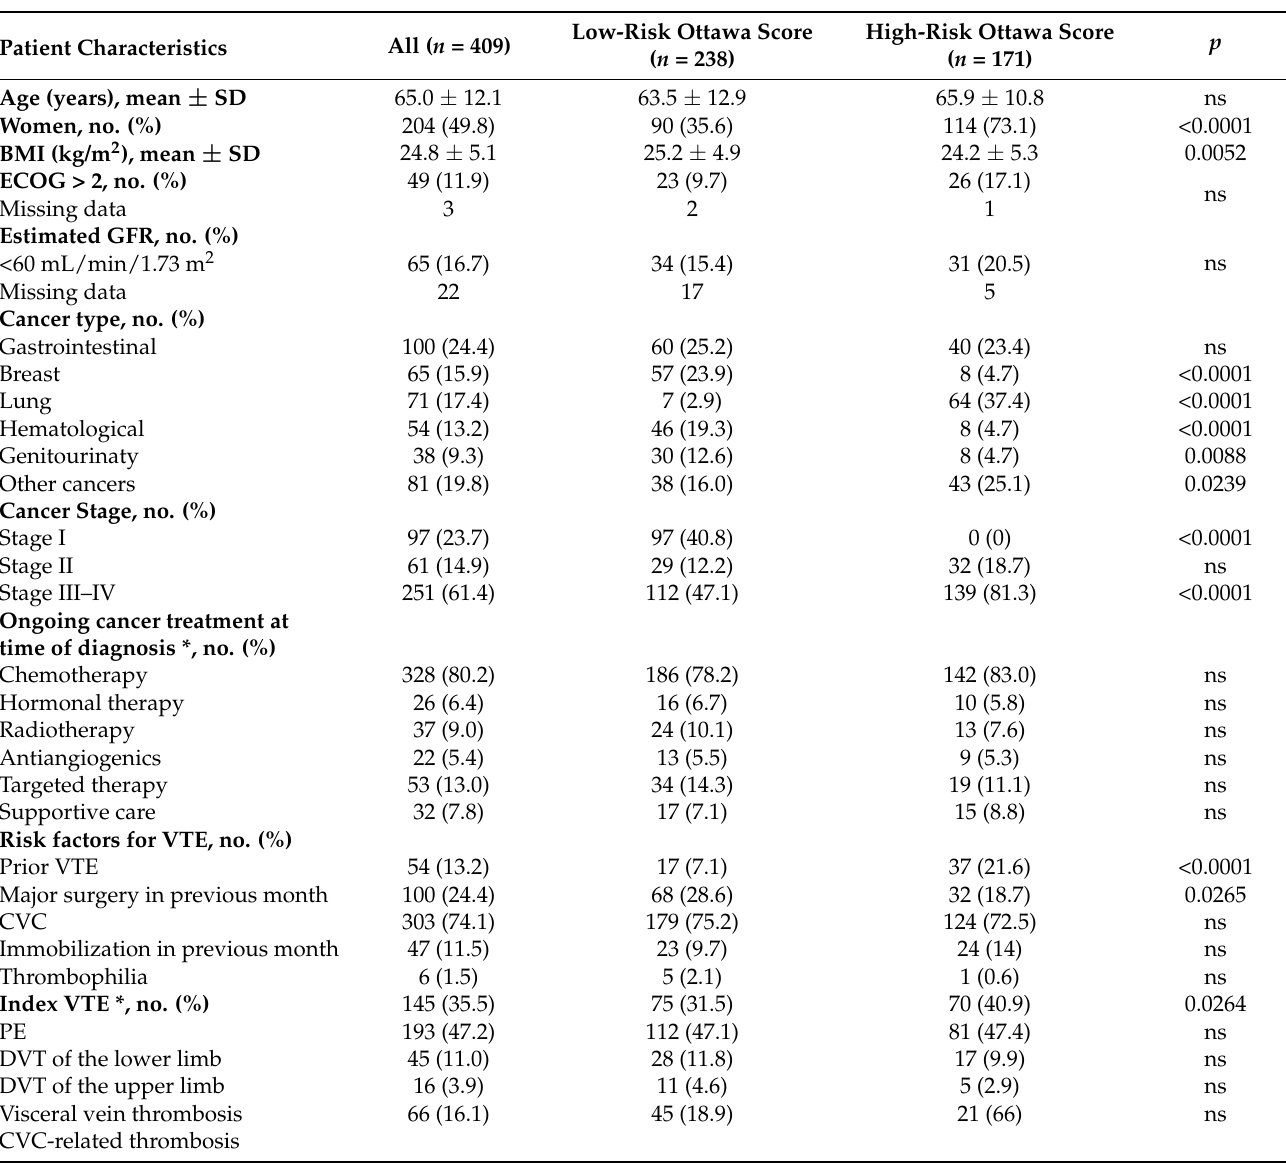
Table 1. Baseline characteristics of patients included in the TROPIQUE